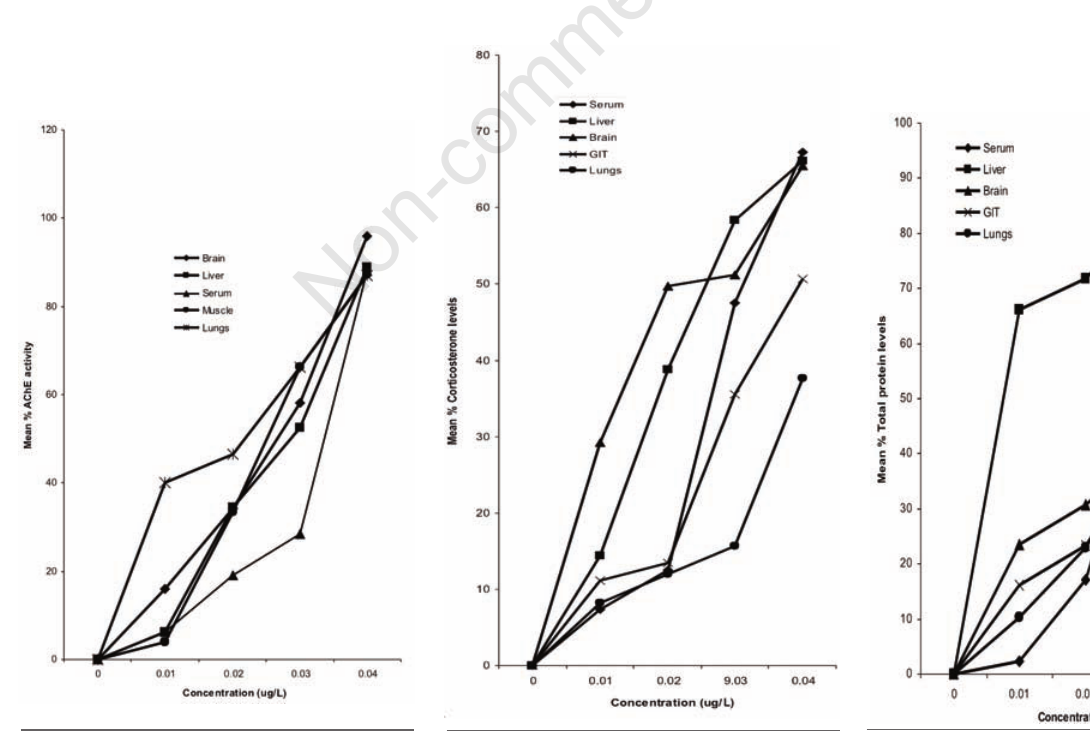
Figure 3. Percentage reduction in total pro- tein levels in organ/tissues of Bufo regularis exposed to diazinon for 28